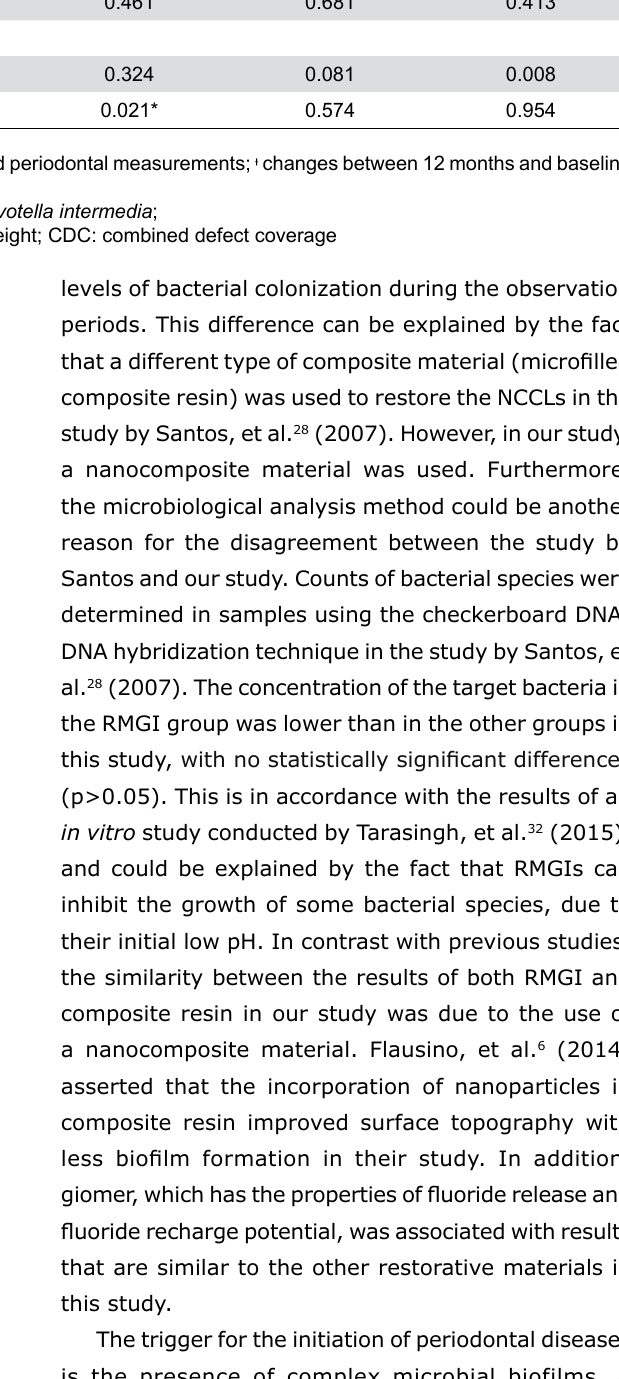
* p<0.05, statistically significant correlation between Pg, Td, Pi and periodontal measurements; ᶧ changes between 12 months and baseline in counts of bacterial DNA copies; Pg= Porphyromonas gingivalis ; Td= Treponema denticola ; Pi= Prevotella intermedia ; rCAL: relative clinical attachment level; CDH: combined defect height; CDC: combined defect coverage